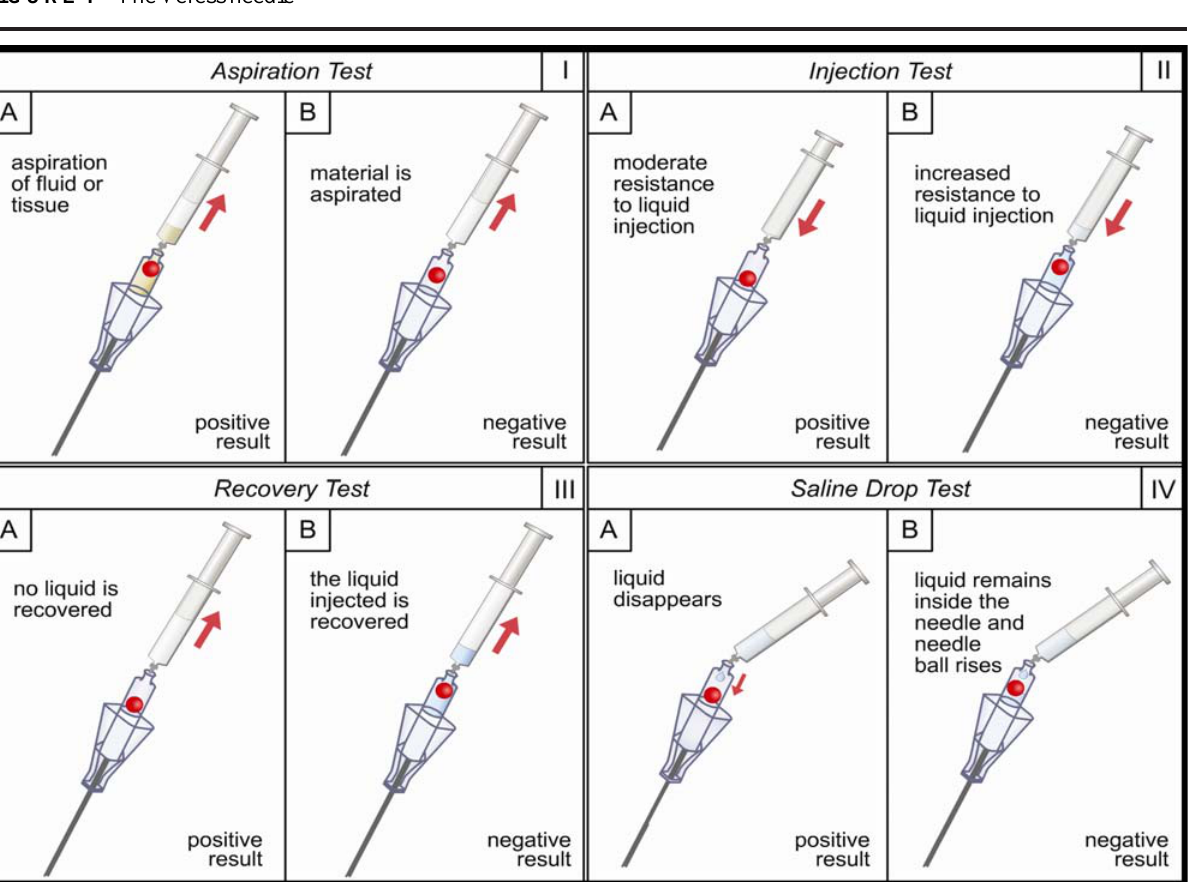
FIGURE 3 - Needle positioning tests: Aspiration test: aspiration using a 5 ml syringe with a Veress needle. This test was considered positive when no material was aspirated (I-A), and negative when any material was aspirated (I-B). Injection test: injection of 5 ml of saline